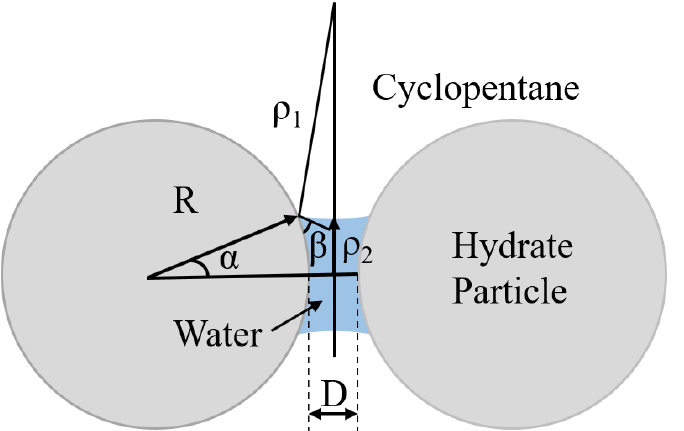
Figure 5. Schematic diagram of liquid bridge between hydrate particles. R * is the radius of the hydrate particle (m); μ is the viscosity of the liquid inside the liquid bridge (P·s); D is the interparticle distance (m); α and β are the half-filling and contact angles (degree); ρ 1 is the radius of curvature of the outer contour of the liquid bridge (m); ρ 2 is the neck radius of the liquid bridge (m).